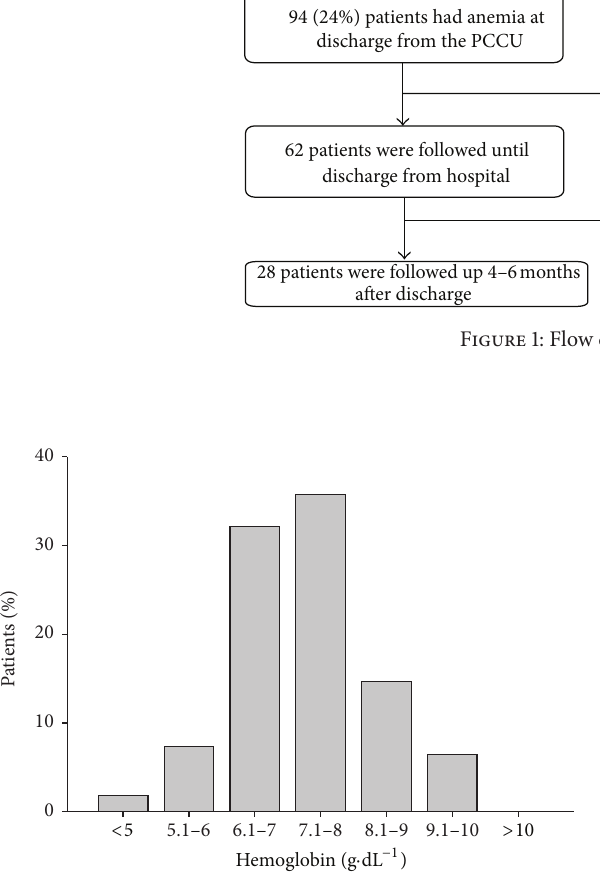
Figure2:Percentageofpatientsreceivingtransfusionsatpredefined hemoglobin thresholds during study